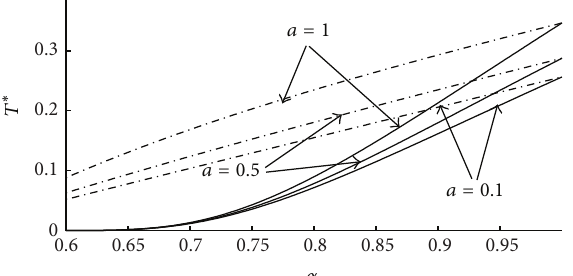
Figure 11: The dependencies for control norm from 𝛼 2 at 𝑝 󸀠 = 1 and several values of 𝛼 1